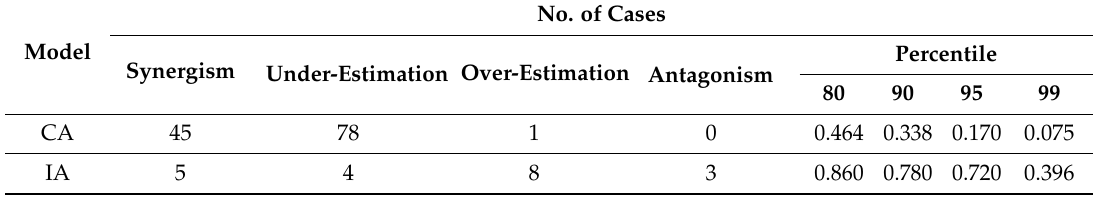
Table 3. Percentile values for model deviation ratios (MDR) and numbers of cases for each group of CA and IA experiments of BP toxicity